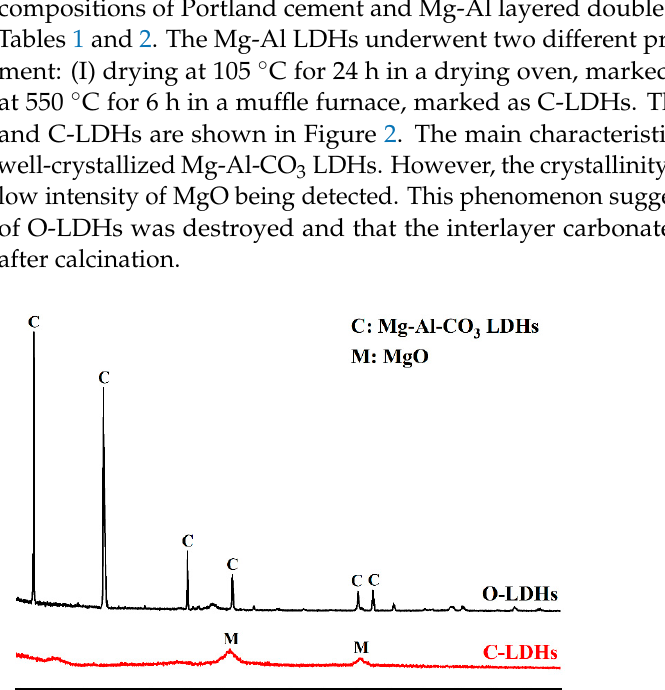
Table 3. Mixture proportions of cement paste.